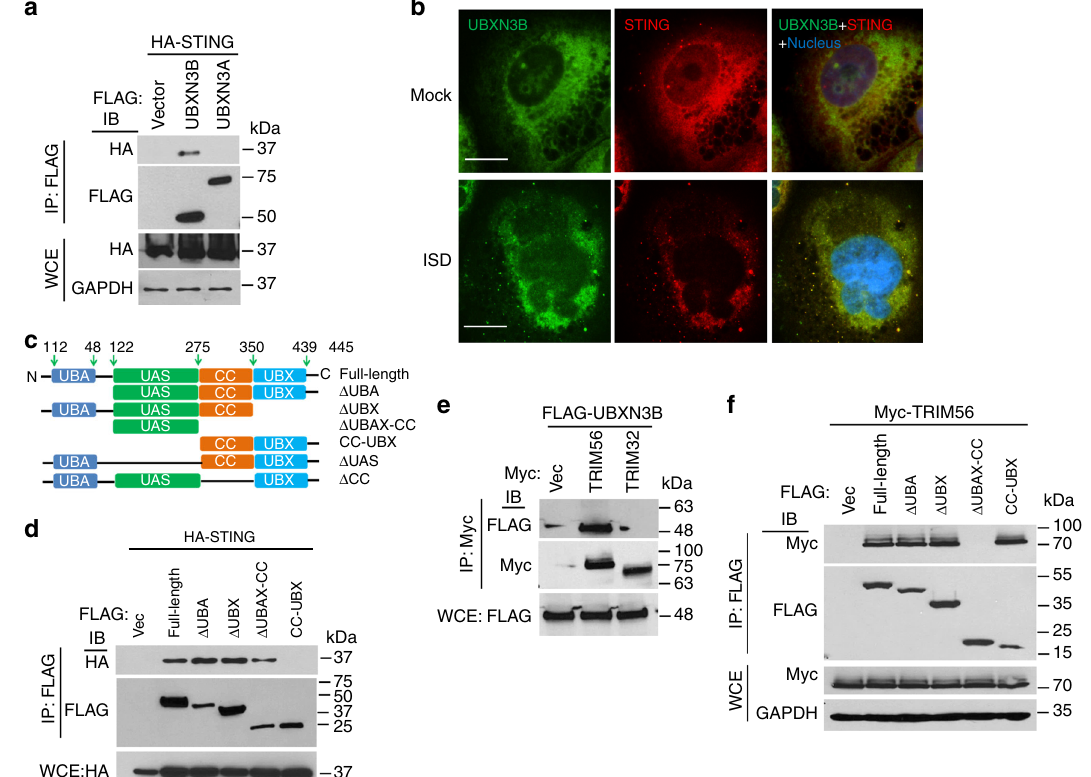
Fig. 5 UBXN3B interacts with STING and TRIM56. a Co-immunoprecipitation (co-IP) of STING with UBXN3B from HEK293 cells transfected with FLAG-UBXNs and HA-STING plasmids using anti-FLAG magnetic beads, followed by immunoblotting (IB) with an anti-HA (STING) and FLAG (UBXN) antibody. b Immuno fl uorescence staining of STING and UBXN3B in H1975 cells treated without (Mock) or with ISD (8 µ g/ml) for 3 h. The cells were stained with a mouse anti-human STING and rabbit anti-UBXN3B antibody followed by a secondary antibody conjugated with Alexa Fluor 594/488. The nuclei were stained with DAPI. Objective, ×40. Scale bar, 200 µ m. c A schematic diagram of UBXN3B functional domains. d Co-IP of STING with the truncated forms of UBXN3B. The procedures are similar to b . e Co-IP of UBXN3B with TRIM from HEK293 cells transfected with FLAG-UBXN3B and Myc- TRIM plasmids using anti-Myc magnetic beads, followed by IB with an anti-Myc (TRIM) and FLAG (UBXN3B) antibody. f Co-IP of TRIM56 with the truncated forms of UBXN3B from HEK293 cells transfected with FLAG-UBXN3B truncates and Myc-TRIM56 plasmids using anti-FLAG magnetic